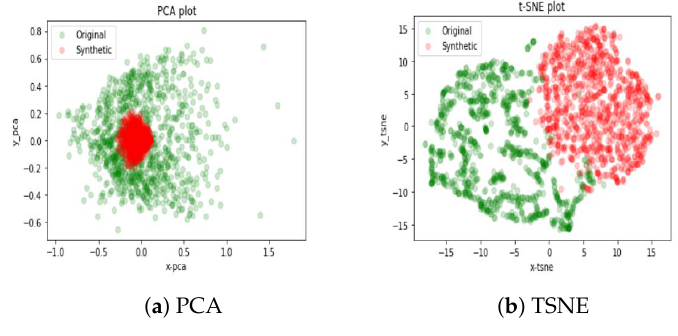
Figure 8. Scenario 2—Adam (lr = 0.0001).